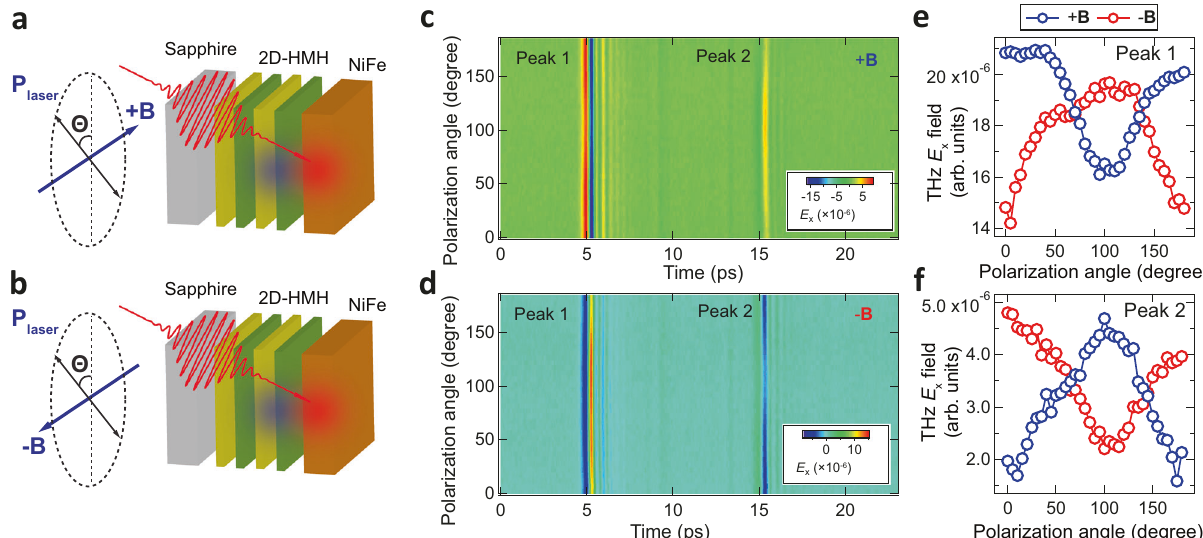
Fig. 4 Pump polarization dependence of asymmetric THz radiation. a , b Schematic illustration of pump polarization dependence of THz measurement in 2D-HMH/NiFe heterostructure as a function of the relative angle ( Θ ) between pump linear polarization axis with respect to the magnetic fi eld. c, d 2D contour plot of the electric fi eld of THz radiation along the x -direction as a function of time and polarization angle ( Θ ), exhibiting strong linear polarization- modulated THz intensity in both two peak groups. Panels e and f summarize the opposite changes of the polarization-dependent THz intensity in Peak 1 and Peak 2 with the switching of the magnetic fi eld,